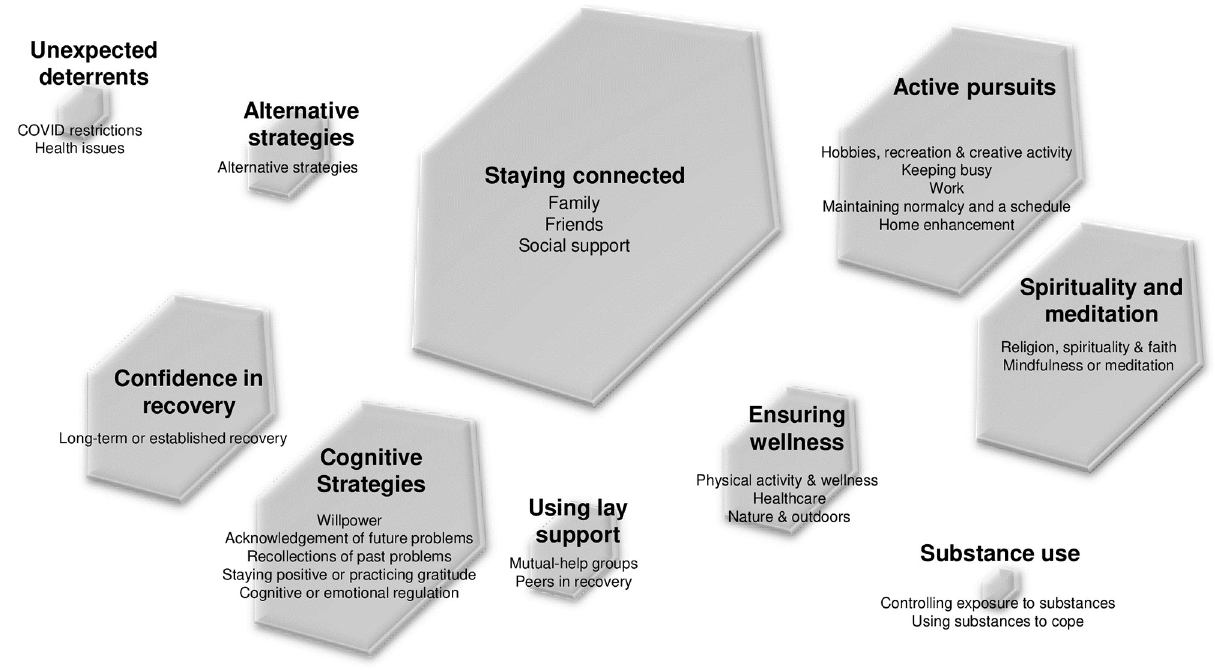
Fig 1. Thematic clusters. Note: The size of the polygon reflects the relative frequency of excerpts included in the theme.